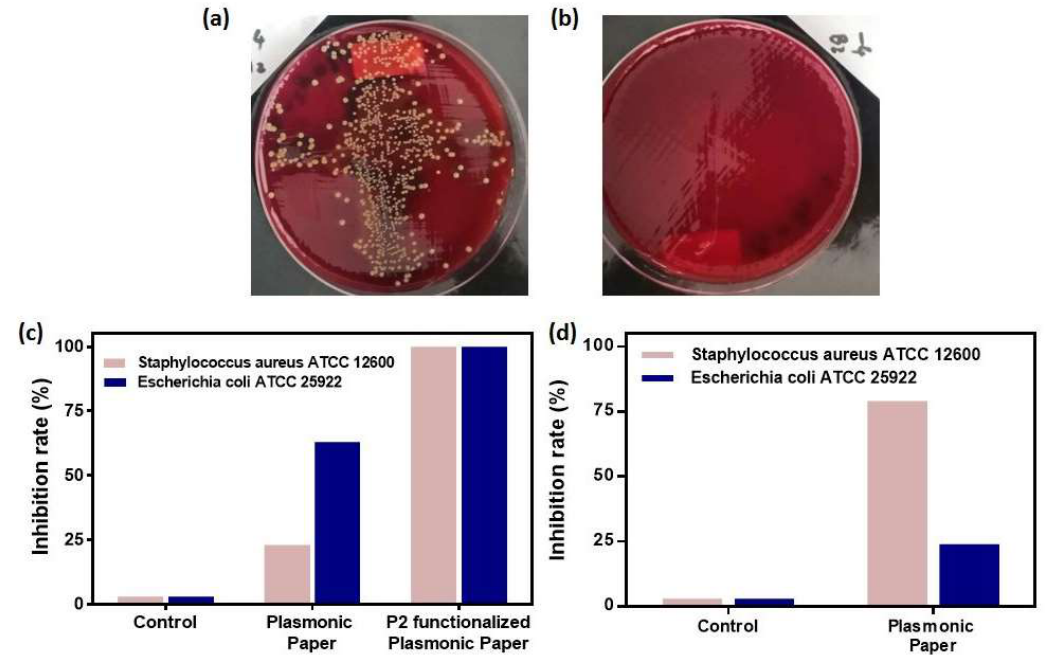
Figure 6. Representative digital images of the colony counting plates with Staphylococcus aureus ATCC 12600 showing the anti-microbial activity against planktonic bacteria without ( a ) and with the P2-functionalized plasmonic paper ( b ); The bacterial growth inhibition rates for ( c ) planktonic bacteria and ( d ) bacterial biofilm determined for the as-designed paper-based nanoplatform when applied to both Staphylococcus aureus ATCC 12600 and Escherichia coli ATCC 25922 bacterial cultures.